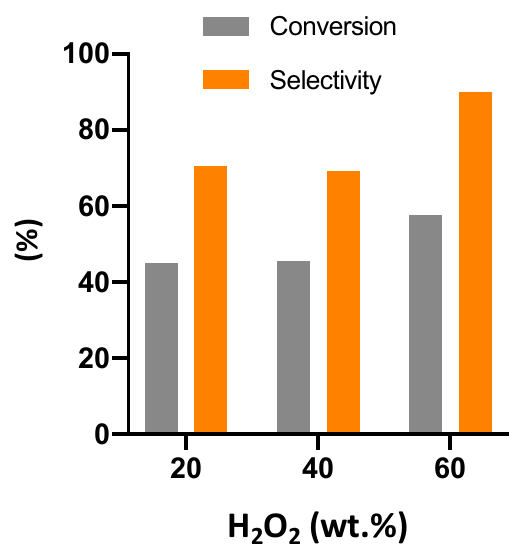
Figure 6. Conversion of double bonds (DB) and selectivity for epoxide for epoxidation in the presence of different initial concentrations of H 2 O 2 . Experimental conditions: 600 mg of catalyst, 5 g (0.024 mol of double bonds) of cardoon oil, reactants molar ratio of 4.5, 20 cm 3 of solvent, and reaction temperature of 78–80 °C.